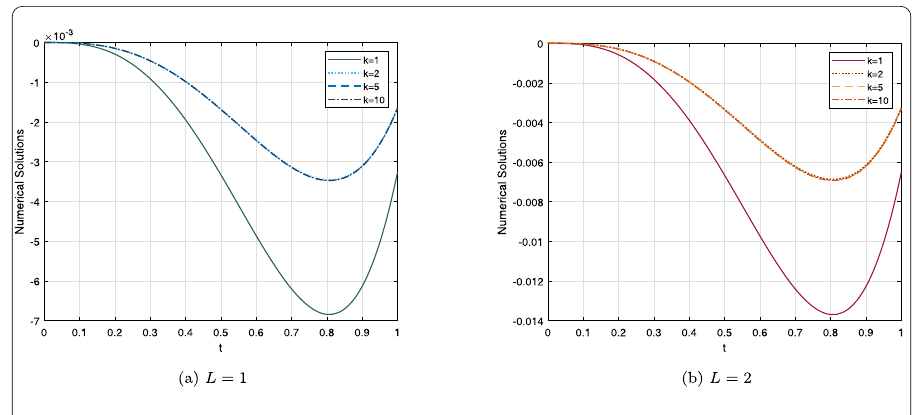
Figure 3 Numerical simulations for Example 4